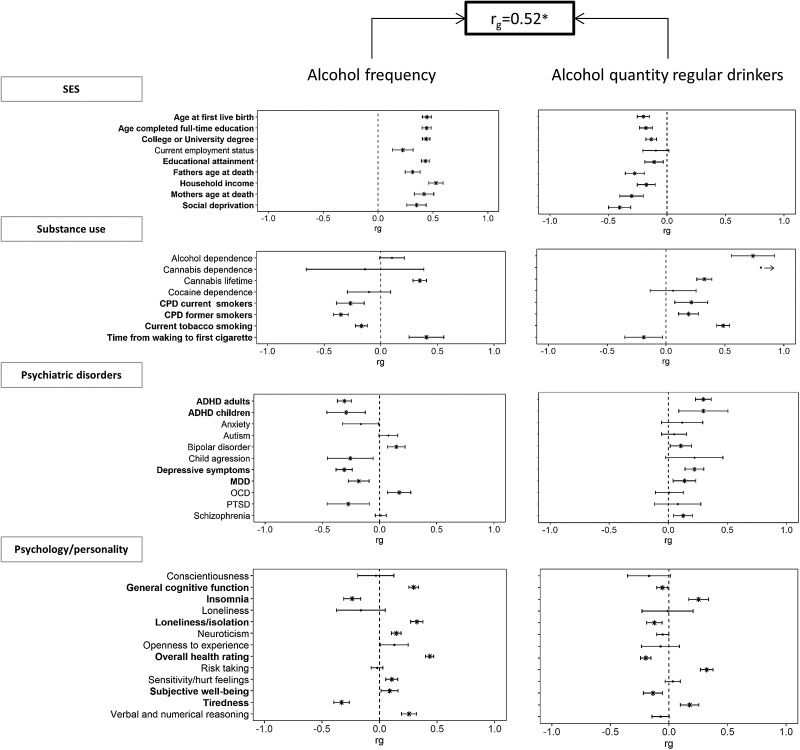
Genetic overlap between alcohol frequency (left panels) and alcohol quantity (right panels) against four categories of traits; SES, substance use disorders, psychiatric disorders, and personality/psychological traits. Traits printed in bold show opposite directions of effect. The error bars represent 95% confidence intervals, an arrow towards one indicates confidence interval >1 or −1, asterisks indicate significant associations (FDR-adjusted p-value <0.05). Social deprivation scores were reversed so that higher social deprivation/Townsend indicates higher SES.